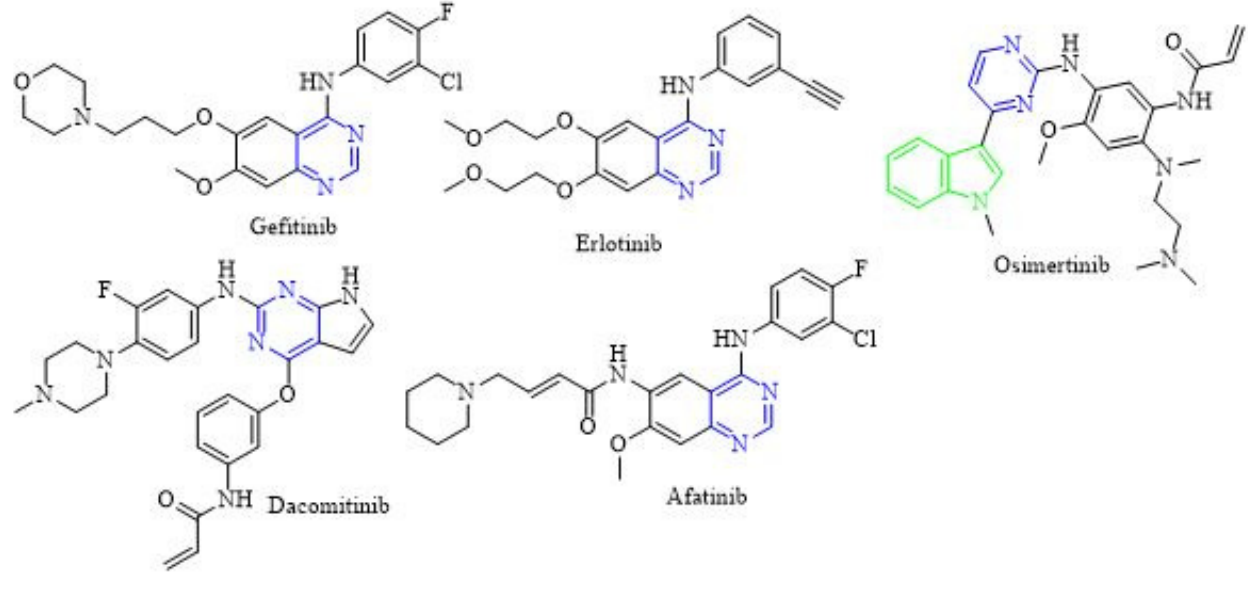
Figure 2. Examples of tyrosine kinase inhibitors that inhibit EGFR.